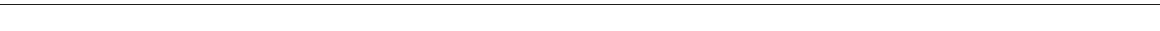
Fig. 9 Ability of ZnO-based non-plasmonic quantum probe for cancerous and non-cancerous diagnosis. a Variation in SERS spectra of cancer and non-cancer cells due to changes in metabolic pathways and changed regulation of surface receptors. b Combination of PCA, DA, and ratio analysis demonstrating ability of disease diagnosis. Multivariate analysis of principal component analysis and discriminant analysis for cell discrimination showed clear distinction between cancer cells and mammalian cells. Scatter plot of Raman intensity ratios at 1445 – 1655cm − 1 ( I 1445 / I 1655 ) separating cancer cells from non-cancer cells. Mean ratio of 1.00 for HeLa and 0.82 for MDAMB separating clearly from non-cancer cell line of NIH3T3 2.34. PCA displays 3D plot of principal components F2 on “ x ” axis F1 on “ y ” axis and F3 on “ z ” axis, whereas DA displays discriminant components F1 on “ x ” axis and F2 on “ y ” axis. Ratio analysis displays cell type on “ x ” axis and ratio ( I I “ y ” axis. c Cell TEM reveal the presence of many quantum probes in the nucleus, cytoplasm, and cell membrane providing 1445 / 1655 ) on label-free, simultaneous, multiplexed detection of DNA, RNA, proteins, and lipids in vitro. Scale bar = 2 µ m for NIH3T3 and MDAMB 231 and scale bar = 200 nm for close-ups (i, ii, iii, iv). d SEM and fl uorescence images of HeLa, MDAMB231, and NIH3T3 cells. Scale bar = 20 µ m. The “ x ” axis of the spectra display Raman Shift (cm − 1 ) and “ y ” axis displays arbitrary units. Mean ratio bar chart includes error bar in S.D. n =